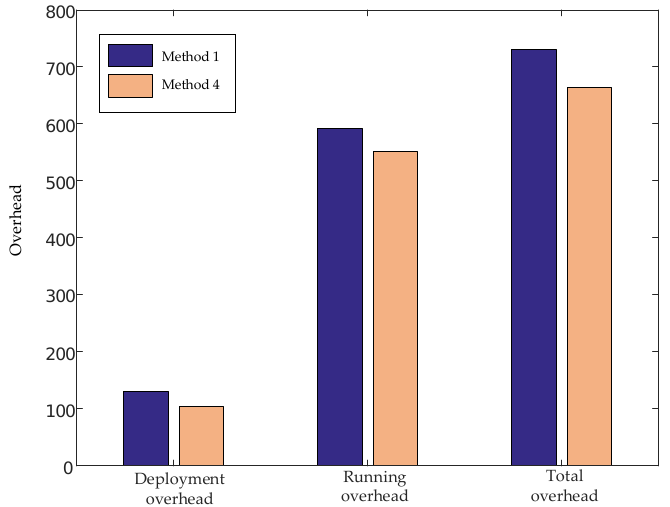
Figure 10. Comparison of network overhead between method 1 and method 4.